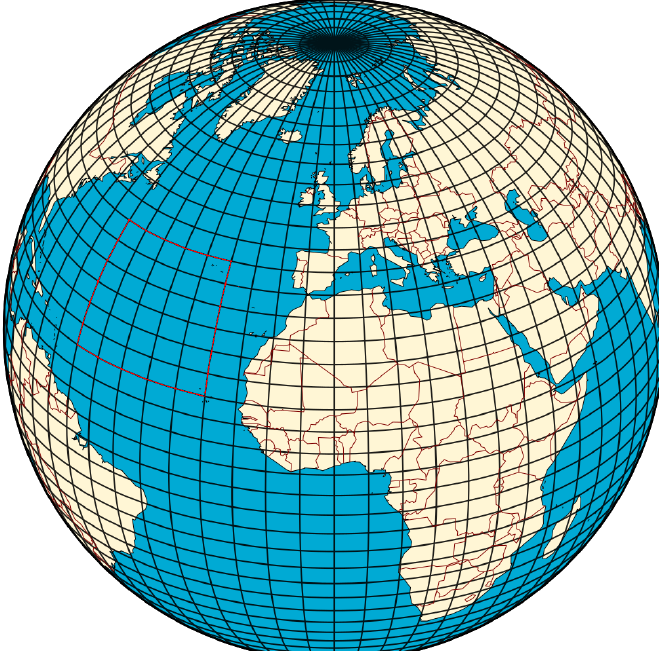
Figure 3. Light-headed grid appearing in discretization of the globe along constant latitudes and longitudes. (Based on a image by Hellerick-Own work, CC BY-SA 3.0,